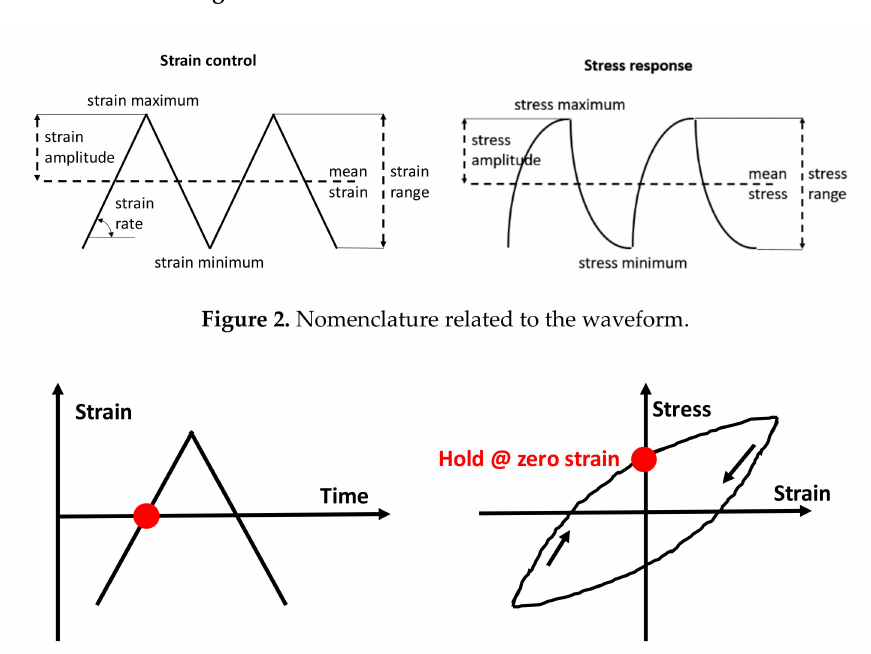
Figure 2. Nomenclature related to the waveform.